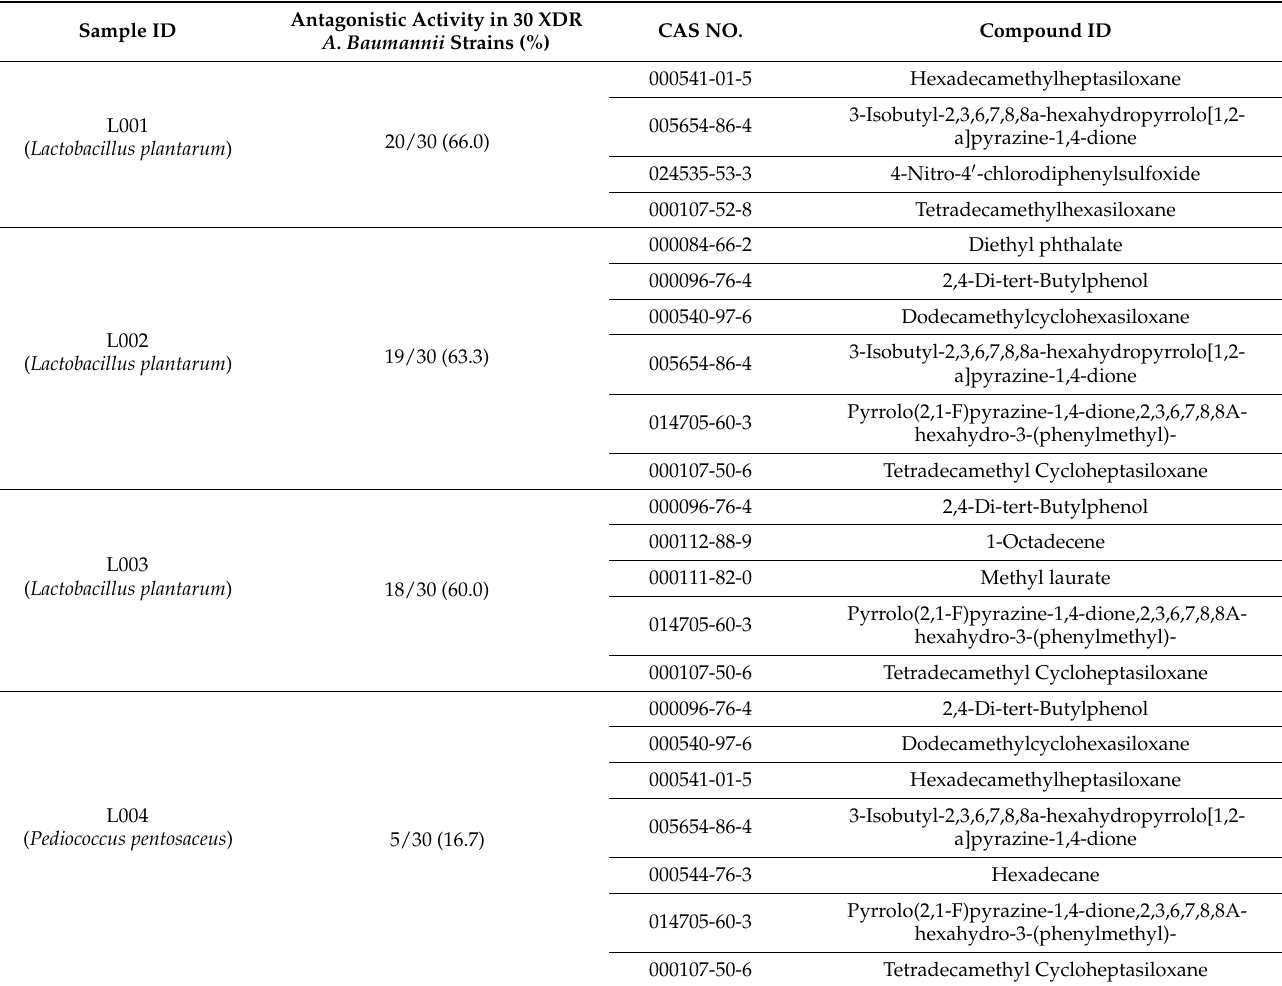
Table 1. List of compounds identified from lactic acid bacteria strains and their antagonistic activity against 30 extremely drug resistance (XDR) Acinetobacter baumannii isolates. Sample ID CAS